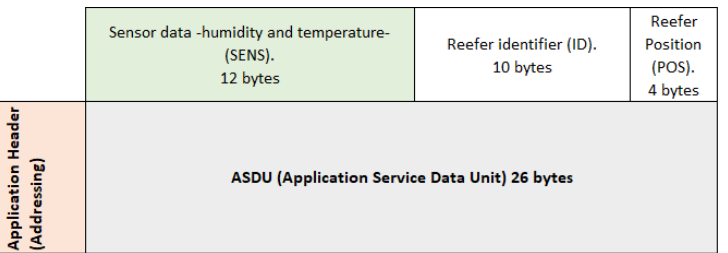
Figure 17. Zigbee Application protocol frame bit reservation for container